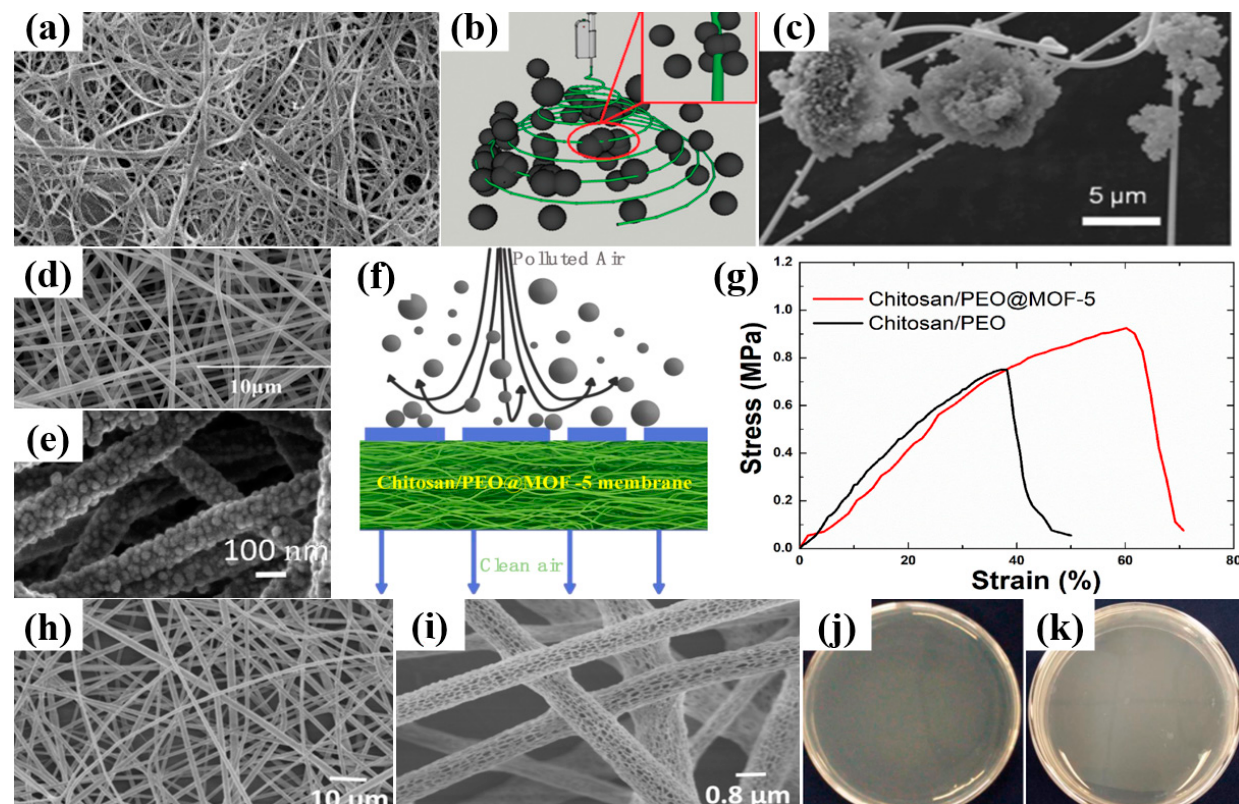
Figure 5. ( a ) SEM micrograph of chitosan nanofibrous matrix [104] . ( b ) Schematic illustration of the mechanism for high-efficiency PM 2.5 capture using polymer nanofibers via in situ electrospinning. Inset: deposition of PM 2.5 on the surface of the nanofibers with high magnification. ( c ) SEM image of the electrospun chitosan nanofibers in the polluted air [96] . ( d ) SEM photograph of HTCC nanofiber membrane [98] . ( e ) High magnification SEM of chitosan/PEO@MOF-5 membrane, growth time 30 s. ( f ) Schematic representation of the polluted air passing through chitosan/PEO@MOF-5 filter for PM removal; ( g ) The stress–strain curves of the freestanding electrospun chitosan/PEO membrane and chitosan/PEO@MOF-5 membrane [99] . ( h , i ) FE-SEM images of the PLA/chitosan fibrous membranes prepared at concentration: 8 wt% PLA, 2 wt% CS. ( j ) Antibacterial activity of